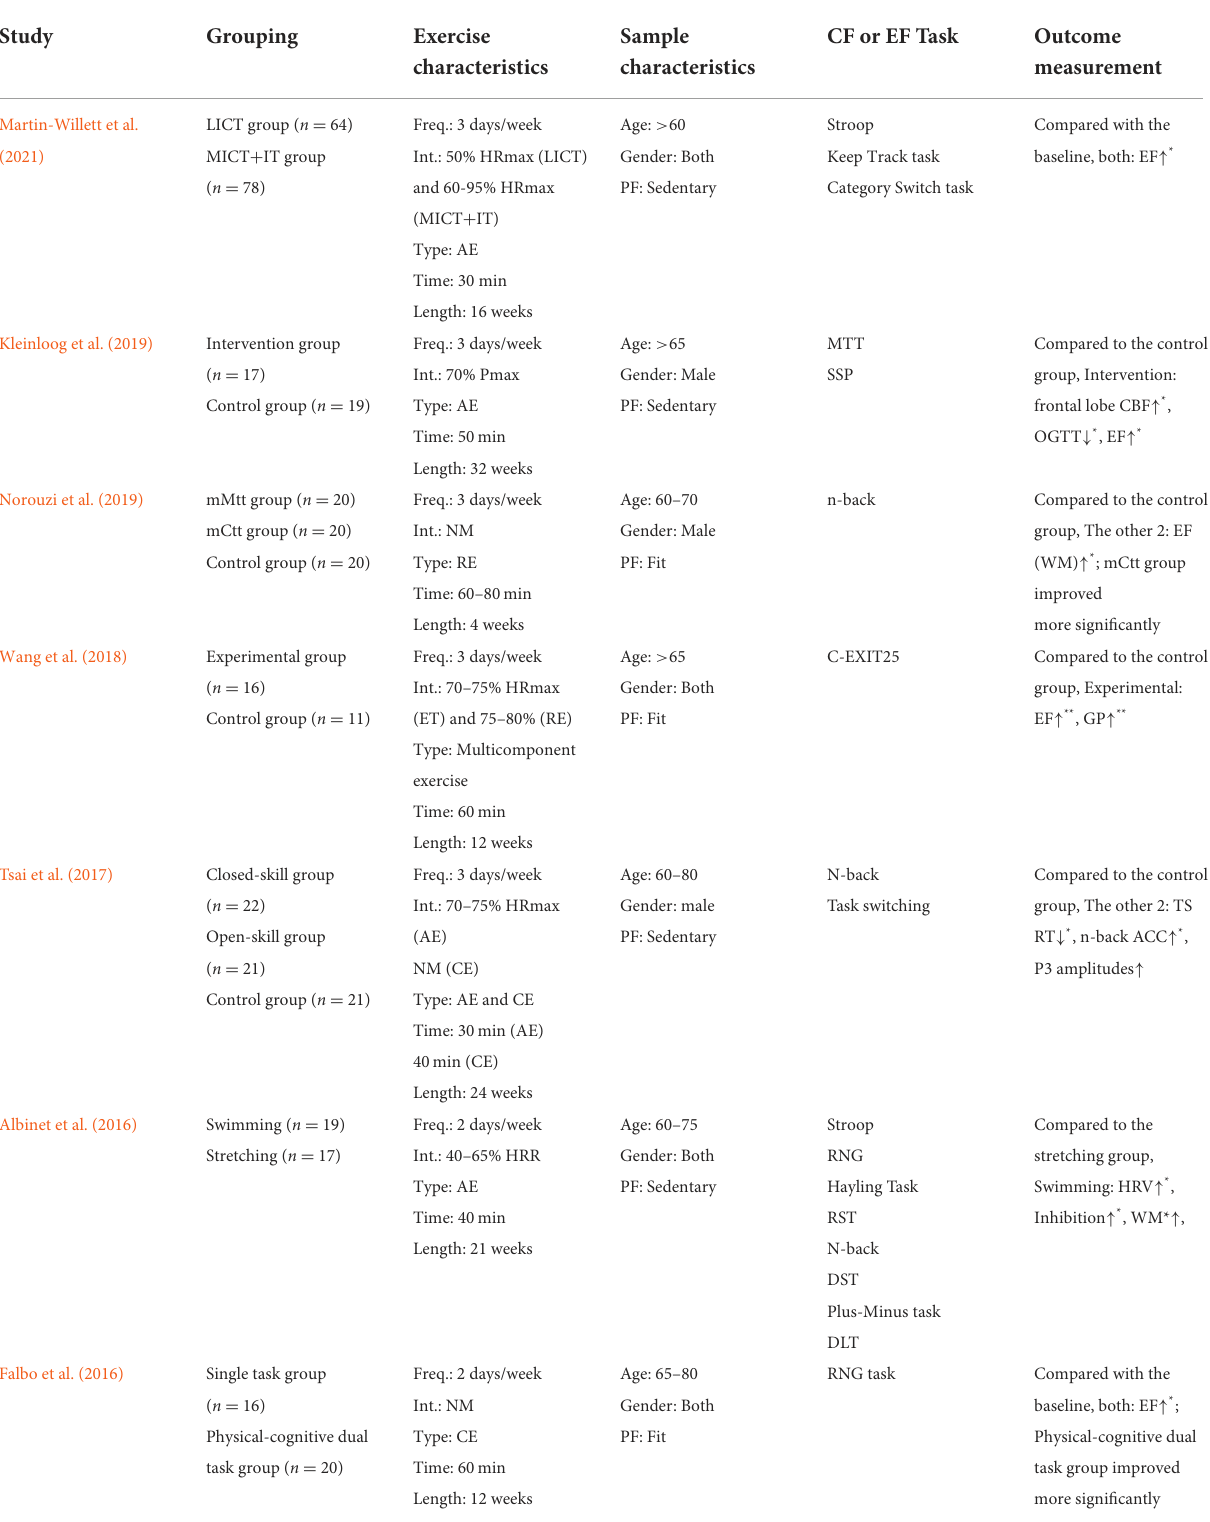
TABLE 1 Intervention characteristics of included studies.